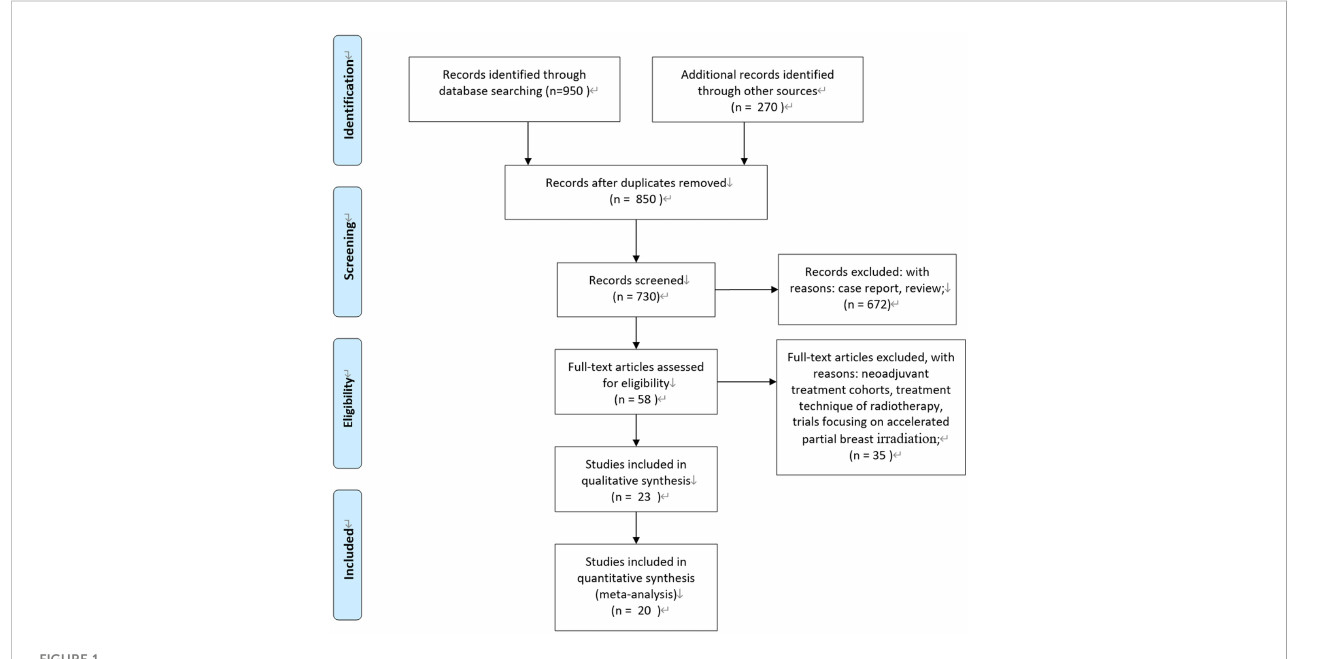
FIGURE 1 PRISMA fl ow